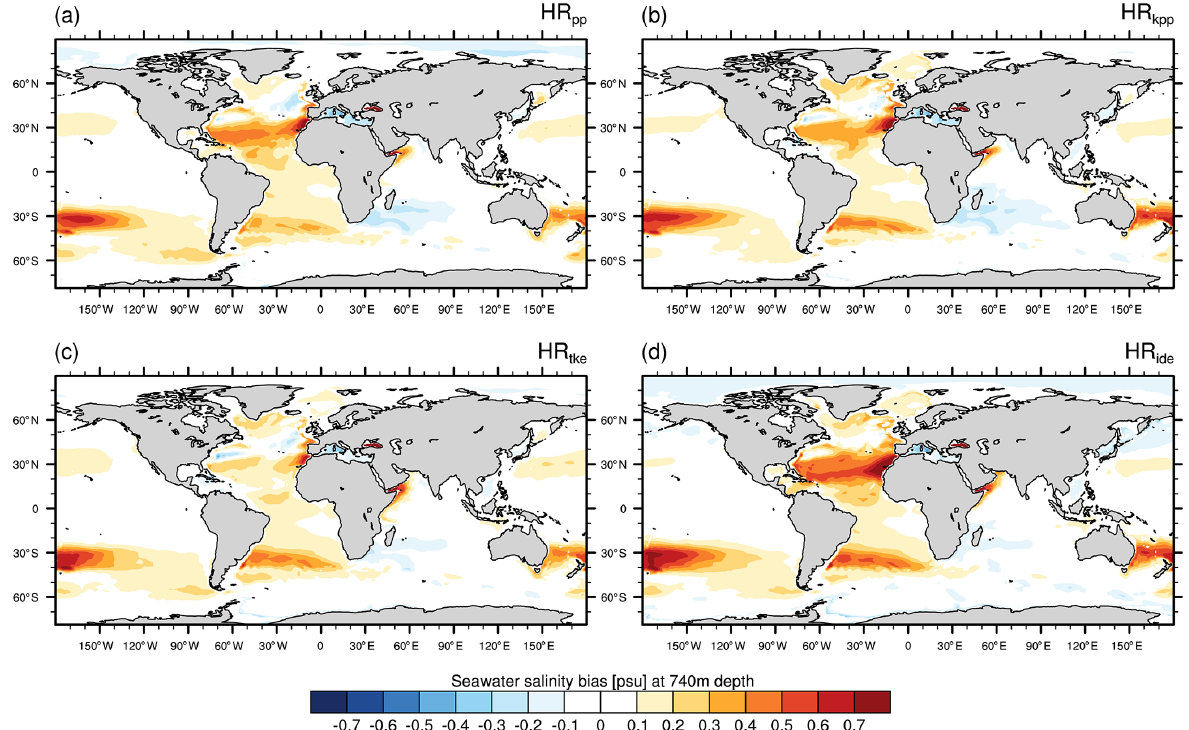
Figure 7. Time-averaged salinity bias of MPI-ESM1.2-HR minus EN4 (1945–1955) at a depth of 740m for (a) HR pp , (b) HR kpp , (c) HR tke , and (d) HR ide